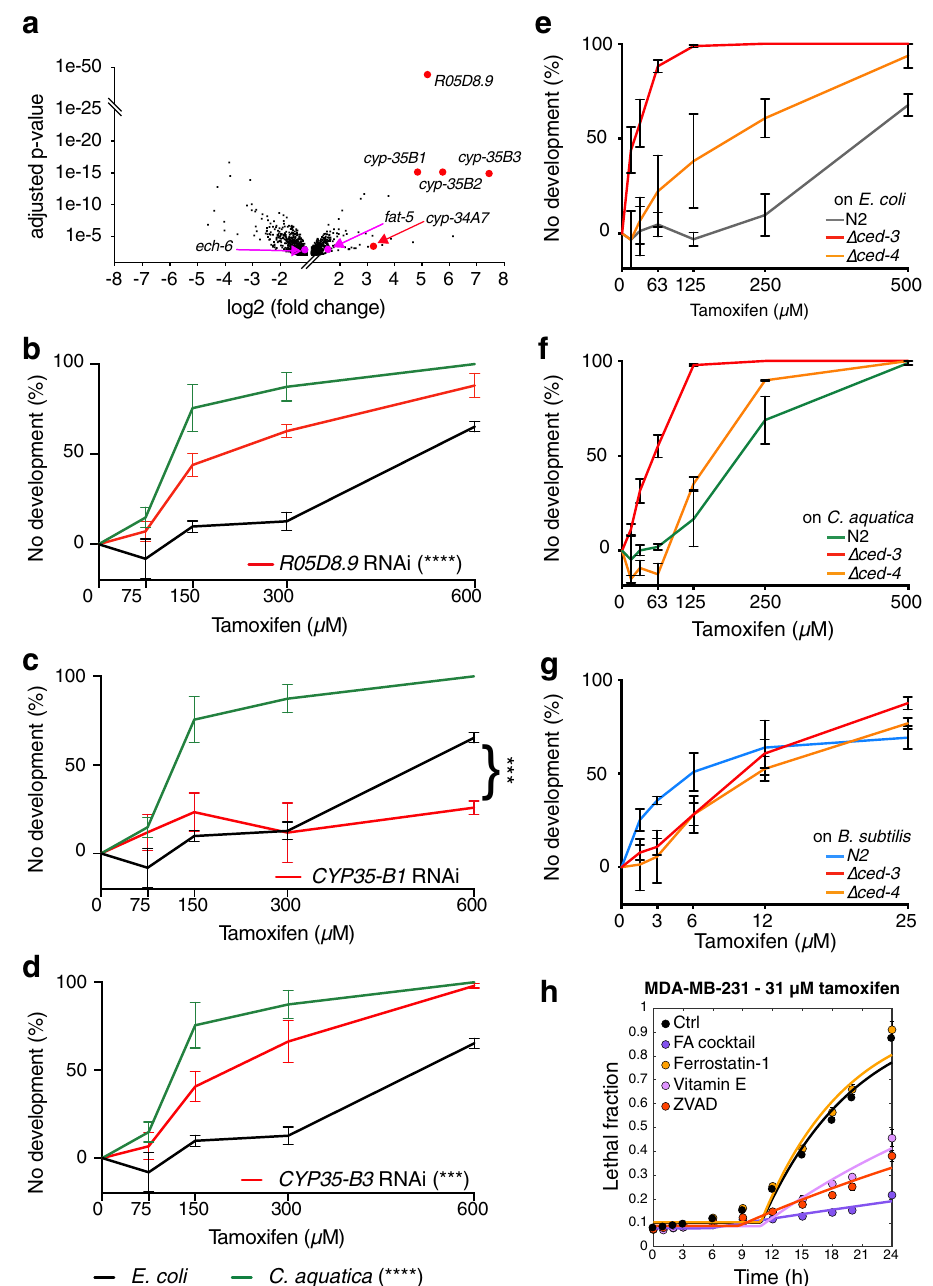
Fig. 6 | Bacteria affect the modulation of tamoxifen toxicity by apoptosis. a Volcano plot distribution of genes whose expression changed signi fi cantly in animalsfed E. coli and exposed to 400 µ M tamoxifen (FDR <0.1, >2-fold change).A full list is provided in Supplementary Data 2. Pink indicates genes encoding enzymes participating in FA metabolism, and red indicates genes encoding enzymes that may be involved in the detoxi fi cation of tamoxifen. See also Sup- plementaryFig.12. b – d DRCsoftamoxifentoxicityinanimalsfed E.coli expressing double-stranded RNA as indicated. Control indicates E. coli containing vector control plasmid (pL4440). Data are represented as mean±SEM of three